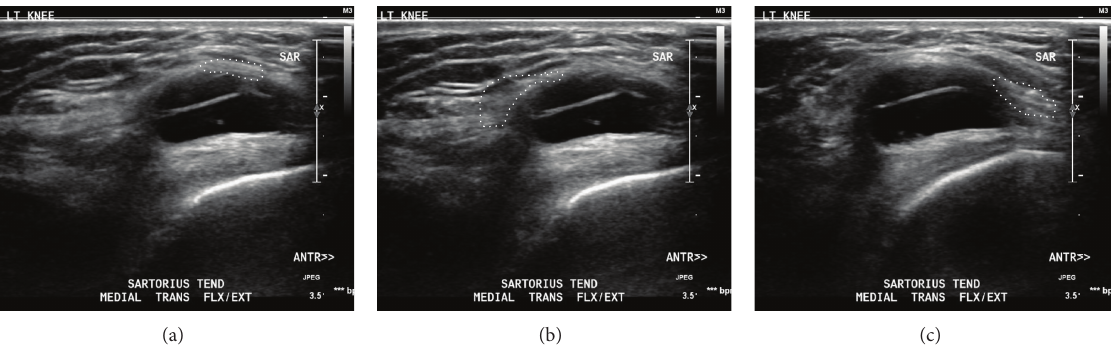
Figure2:Aseriesofdynamicultrasoundimagestakeninkneeflexion/extensioncycle,showingpositionofdistalsartoriusmusculotendinous junction passing over parameniscal cyst; a palpable “snapping sensation” was felt through the transducer: (a) neutral extension; (b) in semiflexion; (c) extension with active quadriceps contraction; note that the tendon of sartorius passes forwards.